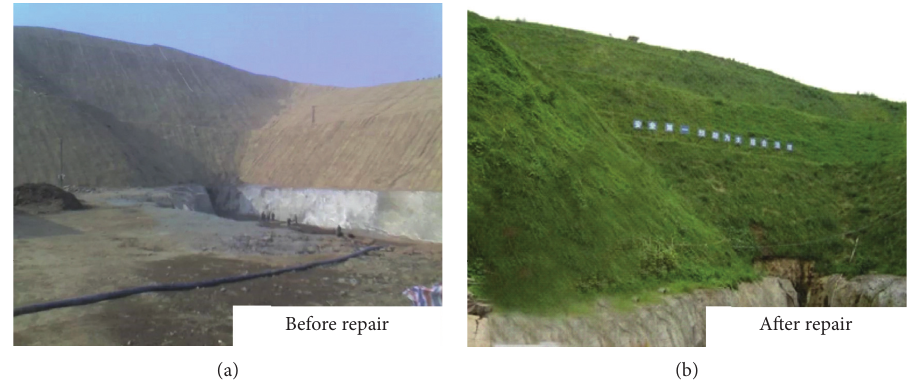
Figure 1: Ecological restoration project of excavation slope from Yanshan reservoir in